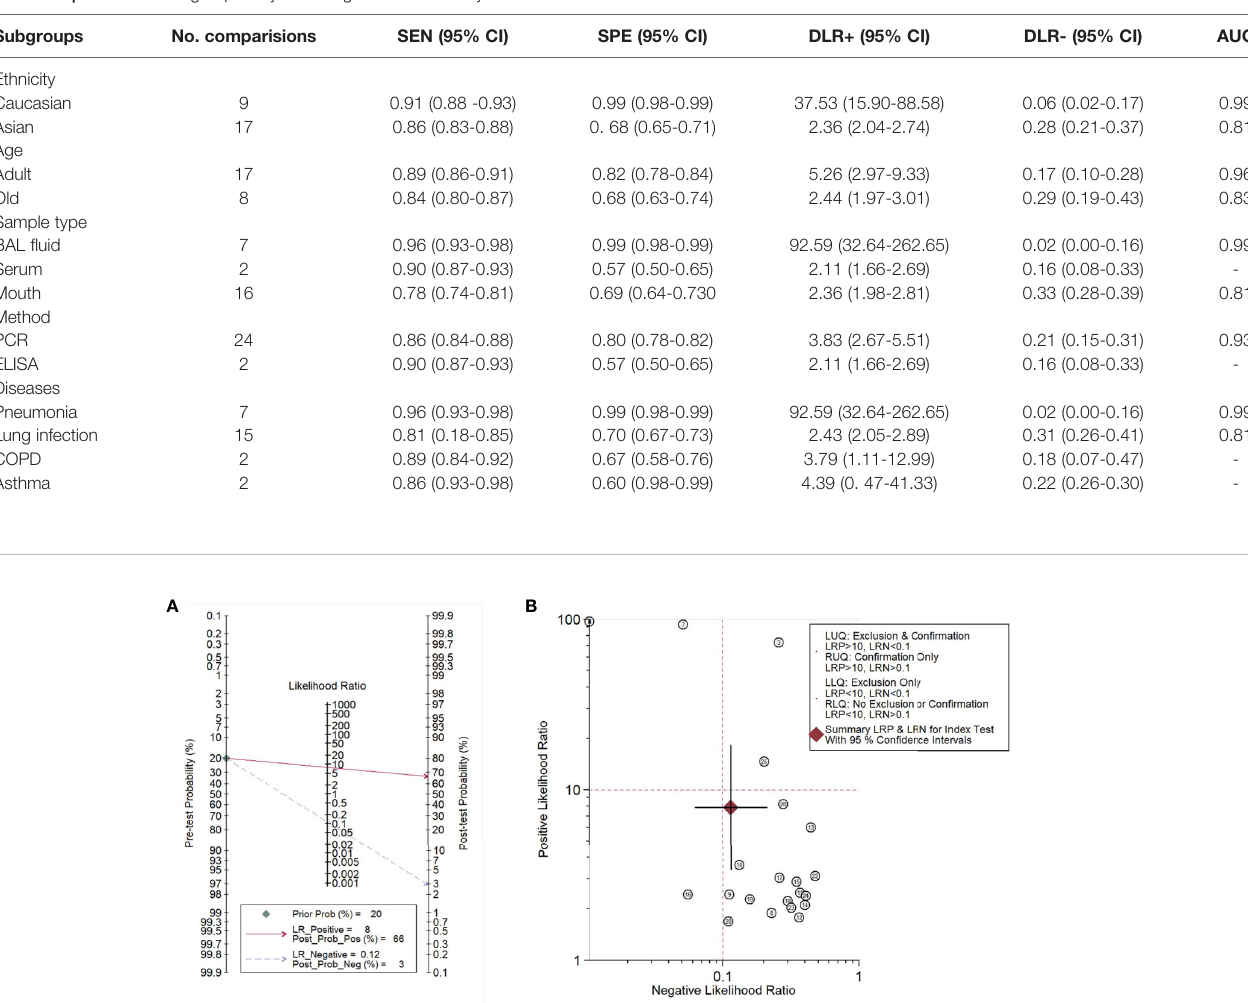
TABLE 2 | Results of subgroup analysis in diagnostic meta-analysis. Subgroups